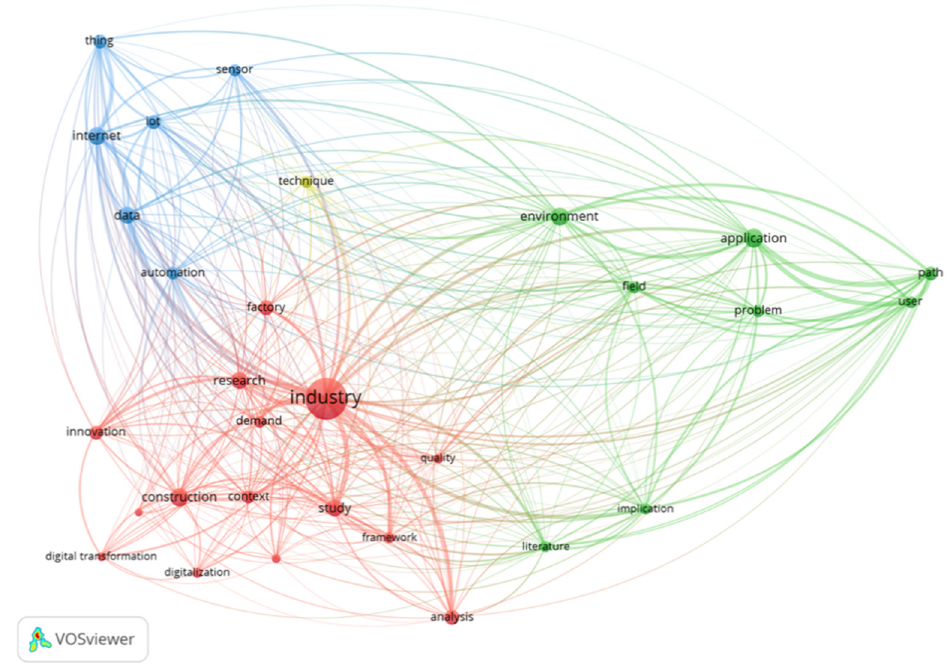
Figure 3. The most commonly co-occurring keyword search related to “Industry 4.0” OR “Industrial revolution 4.0” AND TOPIC “construction” OR “building” in Scopus with 364 publications. Table 3. Cluster of keywords that co-occurred together in Web of Science under keyword search related to “Industry 4.0” OR “Industrial revolution 4.0” AND TOPIC “construction” OR “building”. Cluster